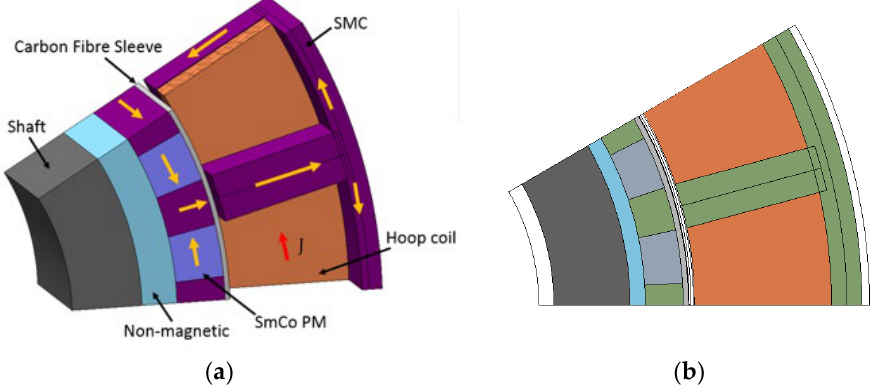
Figure 2. A pole pair of GA optimized TFM, ( a ) Flux concentrating TFM with SMC core; ( b ) 2D view of fully parametric TFM model (before optimization) for FE